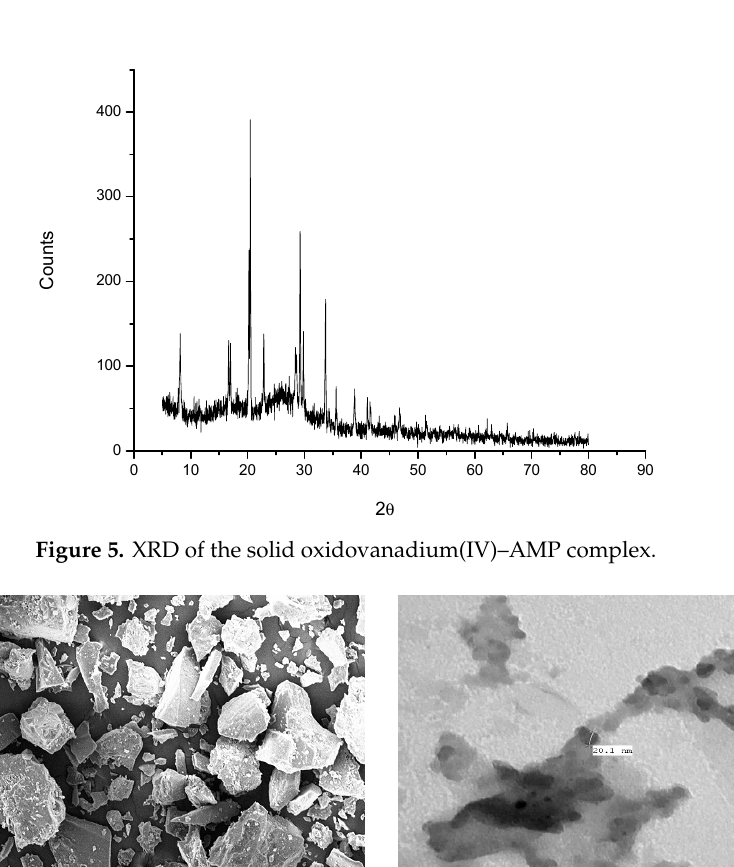
Figure 5. XRD of the solid oxidovanadium(IV)–AMP complex.